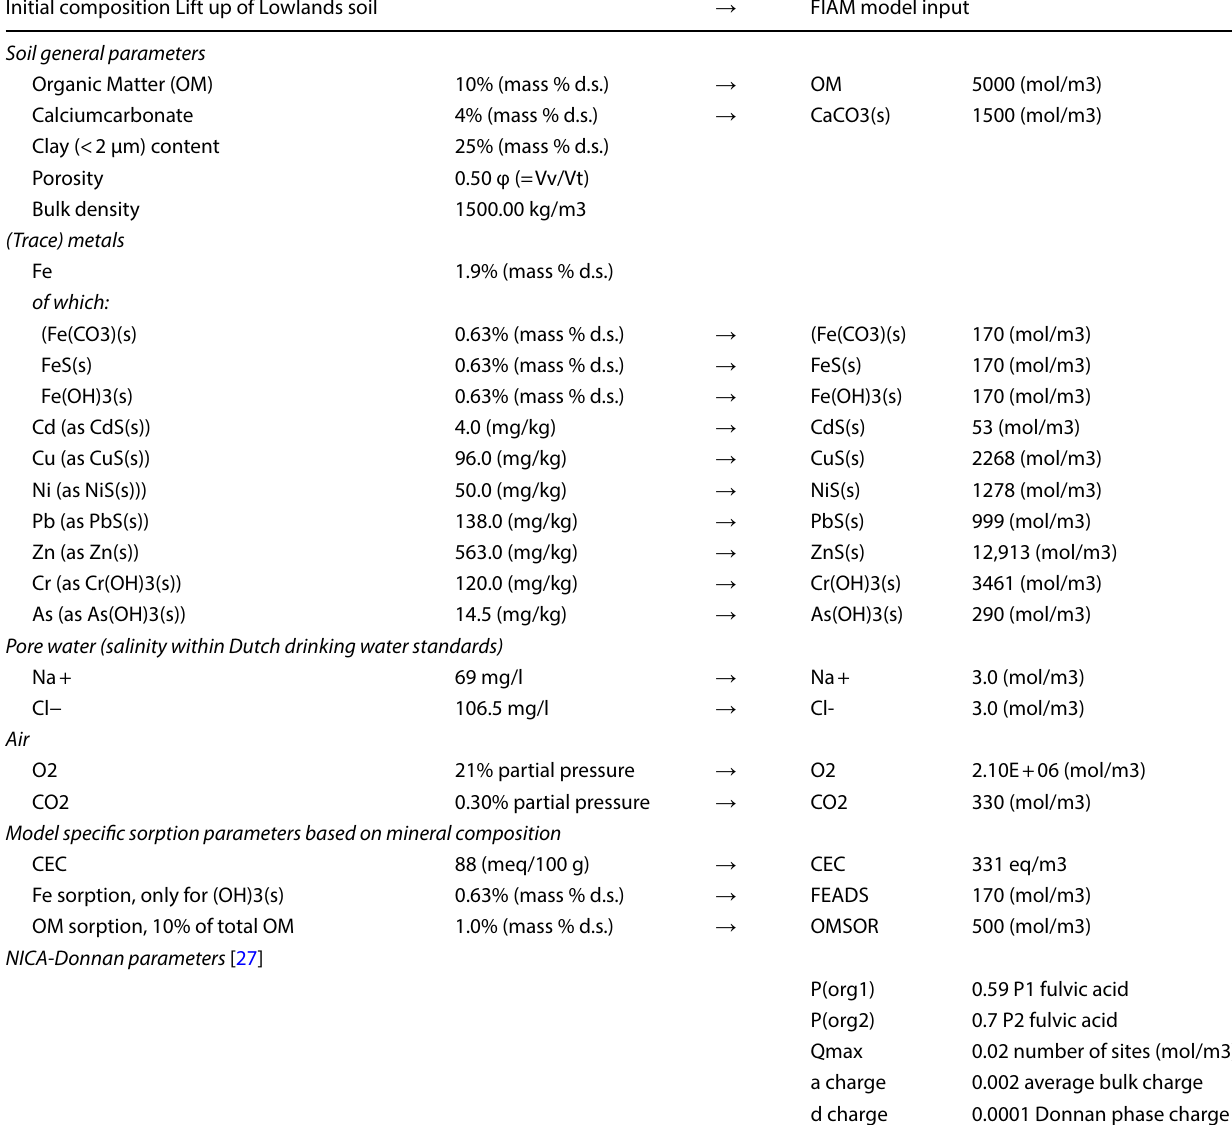
Table 2 Initial soil/sediment composition Lift up Lowlands soil with theoretical metal concentrations (on the left), translated to the FIAM model input (on the right) Initial composition Lift up of Lowlands